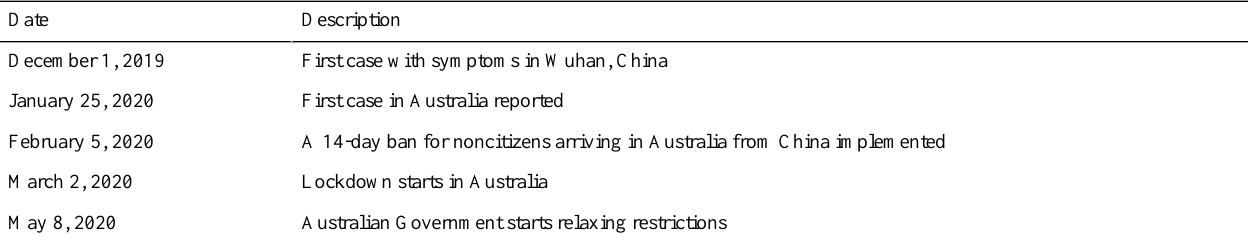
Table 1. Key event dates related to the COVID-19